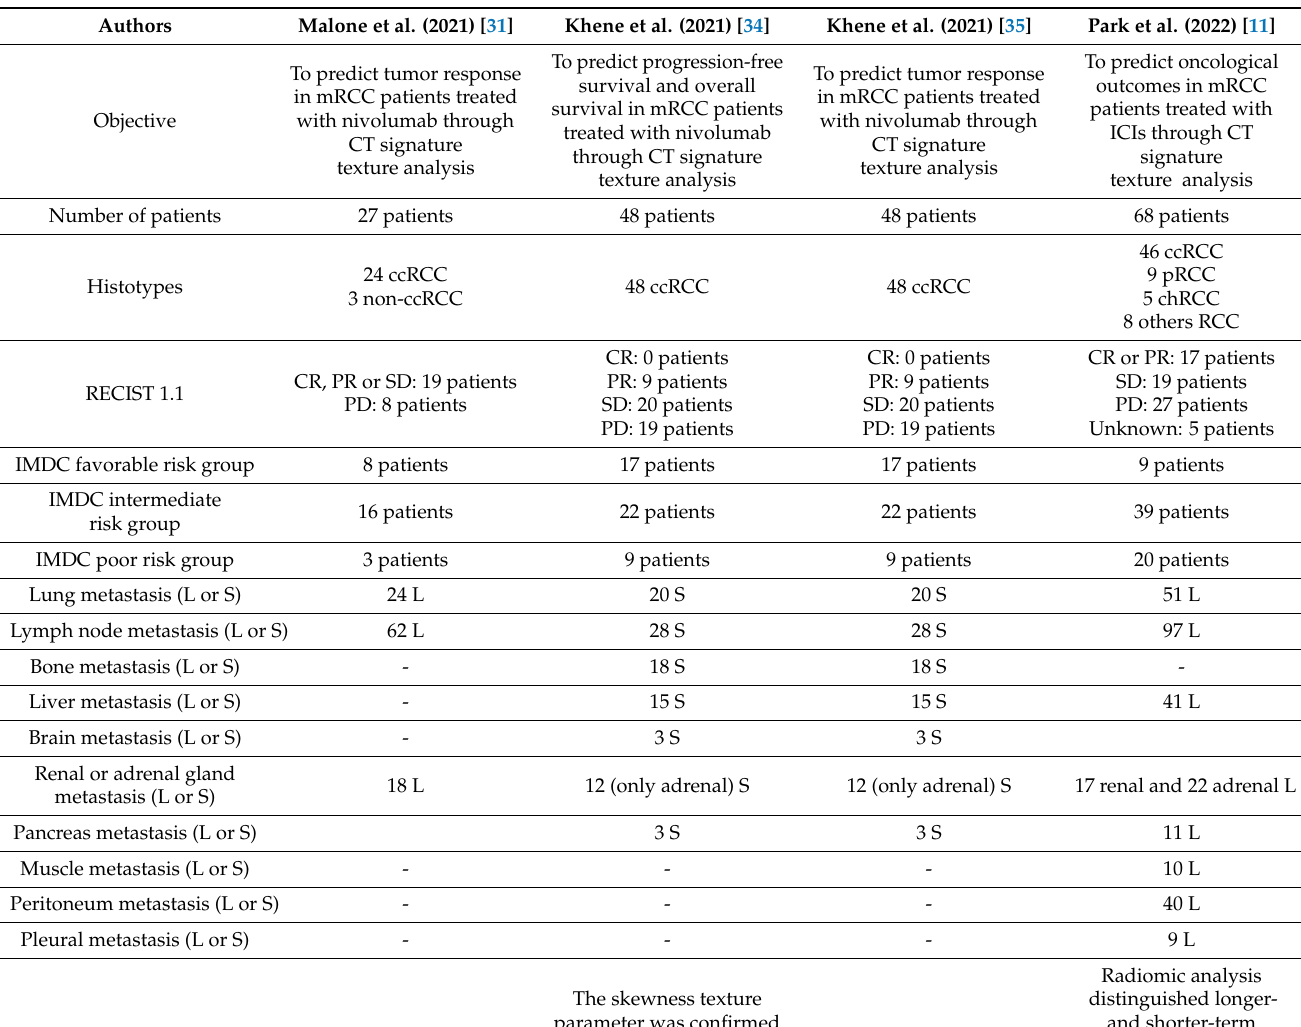
Table 2. Summary of CT predictive clinical studies related to radiomics in mRCC patients treated with